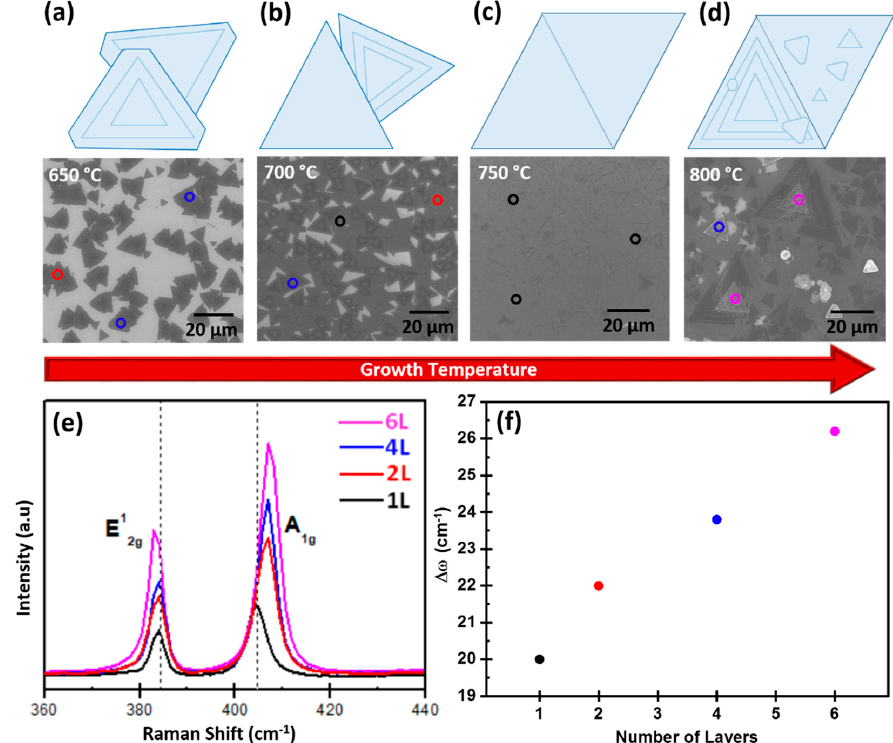
Figure 3. (Top) Schematic of MoS 2 sheet orientation and (bottom) corresponding SEM images of synthesized MoS 2 at various temperatures: ( a ) 650 °C, ( b ) 700 °C, ( c ) 750 °C, and ( d ) 800 °C. ( e ) Raman synthesized MoS 2 at various temperatures: ( a ) 650 ◦ C, ( b ) 700 ◦ C, ( c ) 750 ◦ C, and ( d ) 800 ◦ C. ( e ) Raman spectra at different growth temperatures with the corresponding number of layers. ( f ) Frequency difference between the A 1g and E 12g modes as a function of the number of layers for spectra shown in di ff erence between the A 1g and E 1 2g modes as a function of the number of layers for spectra shown in panel ( e ). panel ( e